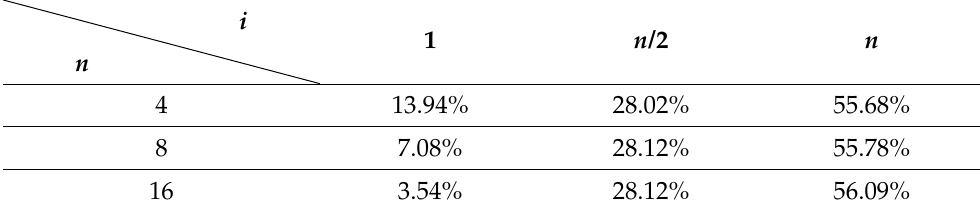
Table 2. Shannon diffusion rates for different values of n in ECB